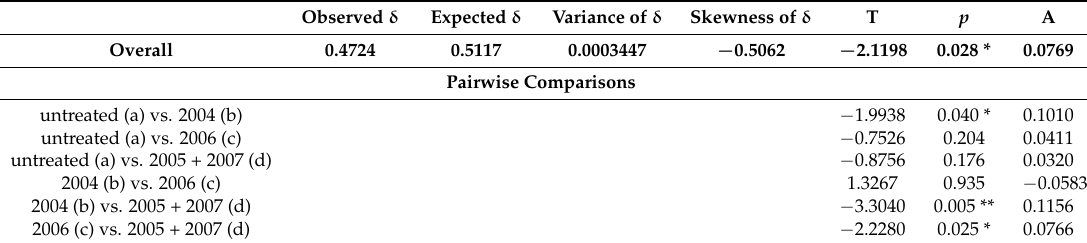
Table 3. Results from multi-response permutation procedures (MRPP) analysis of plant